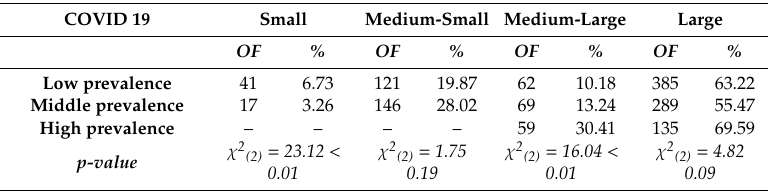
Table 4. Swiss cantons and the Principality of Liechtenstein divided by size (small, medium-small, medium-large and large) stratified by di ff erent prevalence of the coronavirus disease. Percentages were calculated per column.